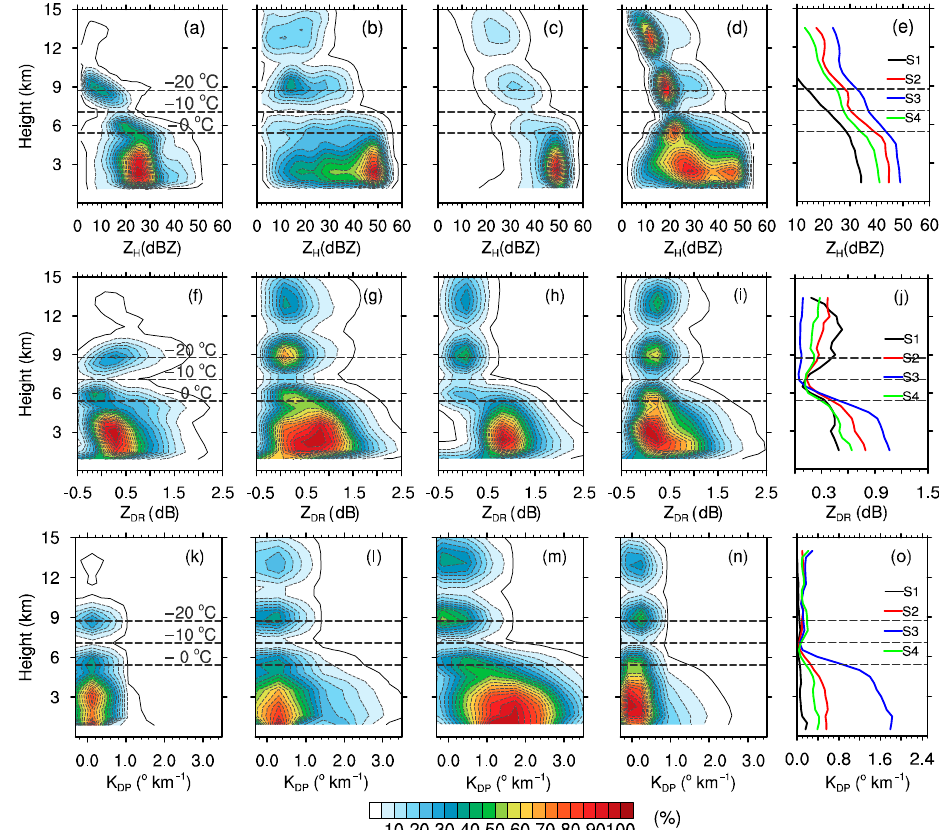
Figure 8. The four left-hand columns: CFADs of the ( a – d ) Z H (dBZ), ( f – i ) Z DR (dB), and ( k – n ) K DR ( ◦ km − 1 ) during the ( a ) initial (S1), ( b ) developing (S2), ( c ) mature (S3), and ( d ) dissipating (S4) stages. Contours and shading represent the frequency of occurrence relative to the maximum absolute frequency in the data sample represented in the CFAD, contoured every 5%. Right-hand column: The averaged profiles of ( e ) Z H , ( j ) Z DR, and ( o ) K DR . The black, red, blue and green lines represent the initial (S1), developing (S2), mature (S3), and dissipating stages, respectively. The black dashed lines represent the level of 0 ◦ C, − 10 ◦ C, and − 20 ◦ C from bottom to top, respectively. During S1, the mean rain rate of Jinjiang was under 0.5 mm (5 min) − 1 with a maximum rain rate of 3.8 mm (5 min) − 1 . The values of Z H below the melting level were